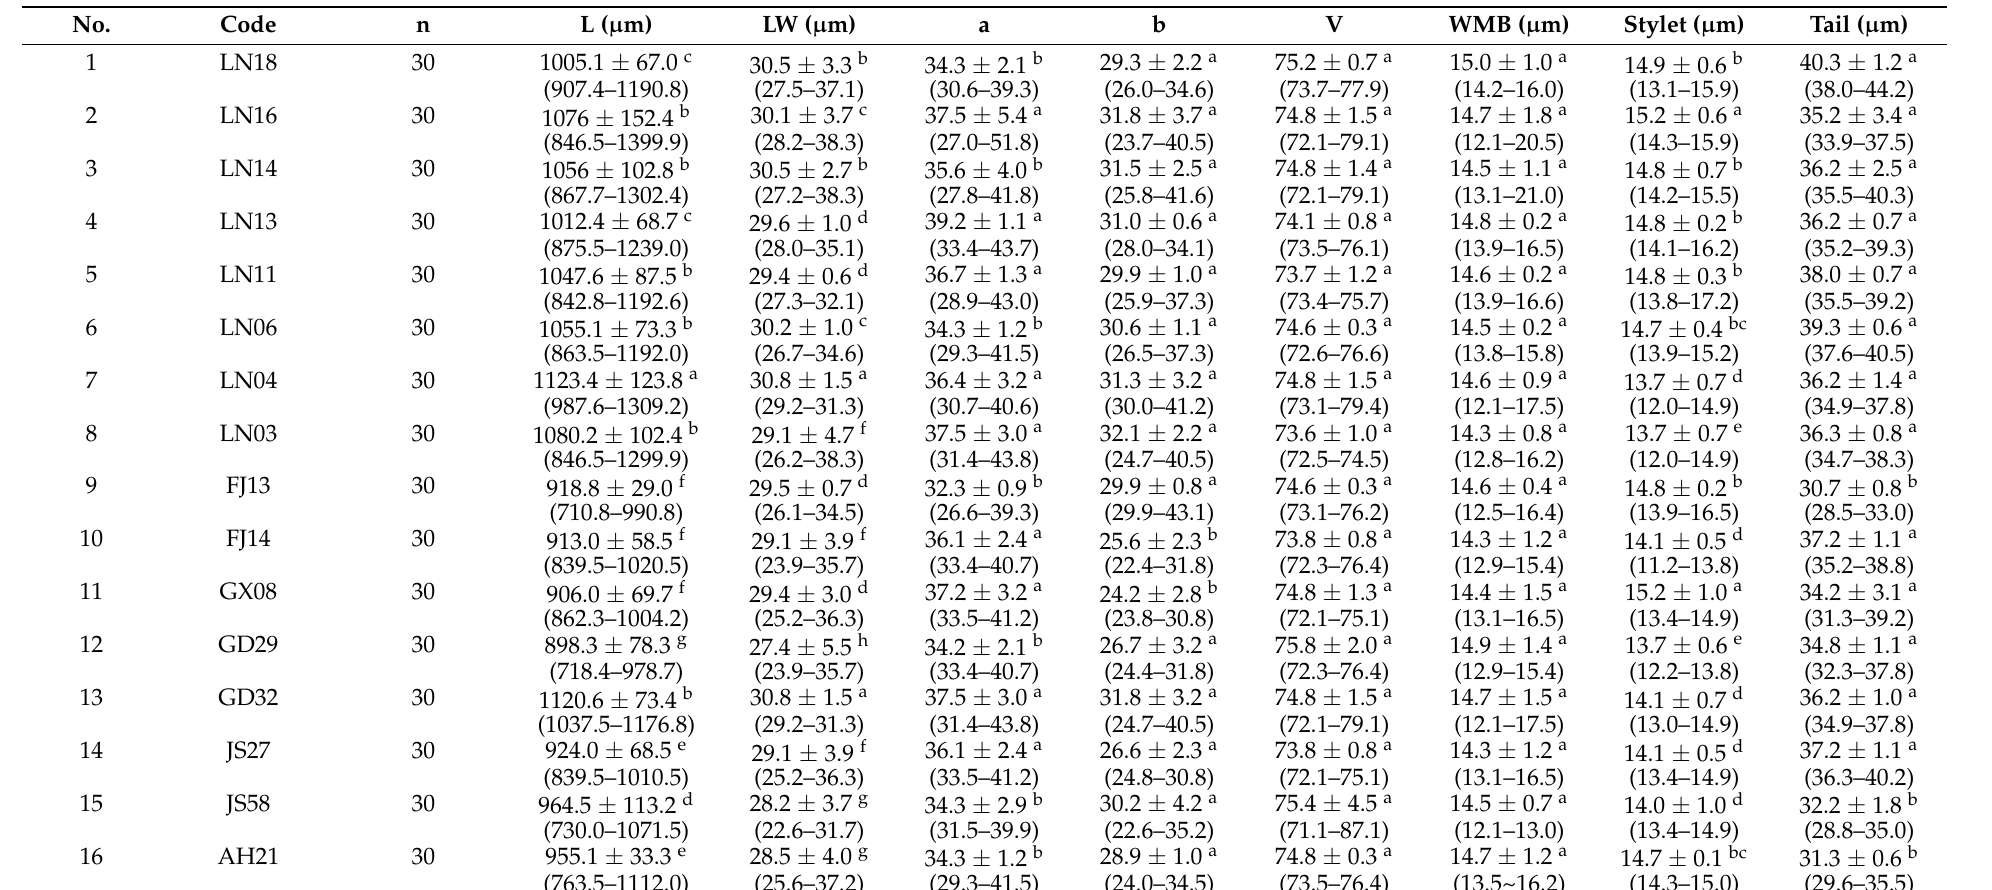
Table 3. Morphometrics of female nematodes in north and south China. L is the body length ( µ m); LW is the maximum body width ( µ m); a is the body length/maximum body width ratio; b is the body length/tail length ratio; V is the distance from the vulva to the top of the head × 100/Body length; WMB is the width of the middle esophageal bulb ( µ m); Stylet is the length of the stylus ( µ m); Tail is the length of the tail ( µ